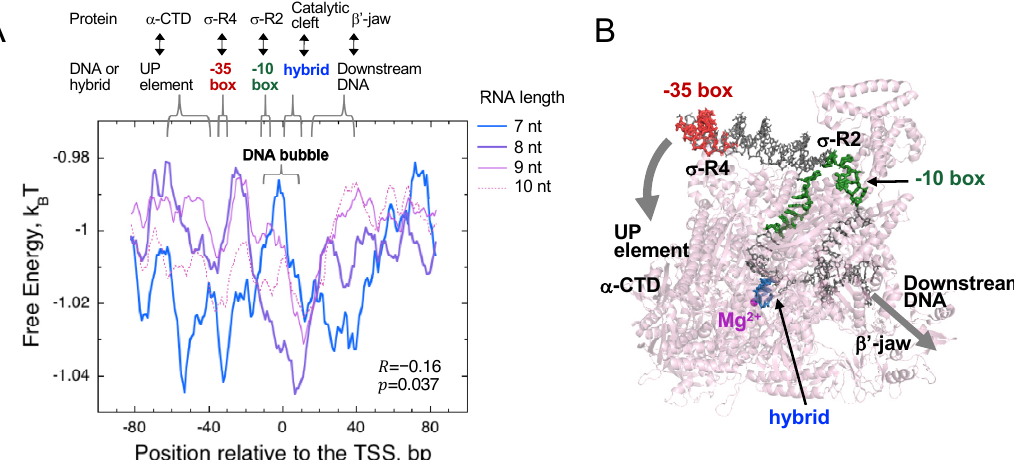
Figure 11. FEINC landscape is altered by the nascent RNA length. ( A ) An opposite trend of the FEINC landscapes is observed between the ternary complexes retaining 7-nt and 8-nt (9 nt and 10 nt) RNA, in the abortive / pausing-enriched group ( X ≥ 2). Pearson correlation coe ffi cient R and the p -value in the comparison of the entire free energy indices between the complexes having 7-nt RNA and 8-nt RNA are shown in the graph. ( B ) X-ray crystal structure of the E. coli initiation complex with 4-bp RNA-DNA hybrid (PDB ID: 4YLN) [53]. Key interactions between holoenzyme and dsDNA / RNA-DNA hybrid that are described in the panel A are also shown within the structure. DNA and holoenzyme molecules are shown by gray and pink colors,